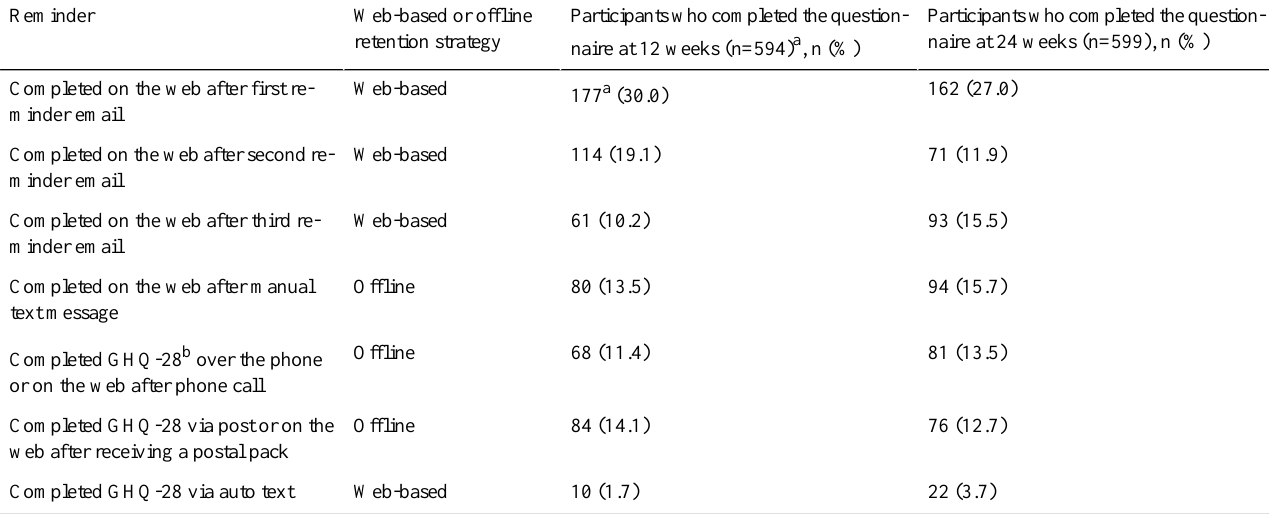
Table 4. Participant completion of the primary questionnaire after each reminder.